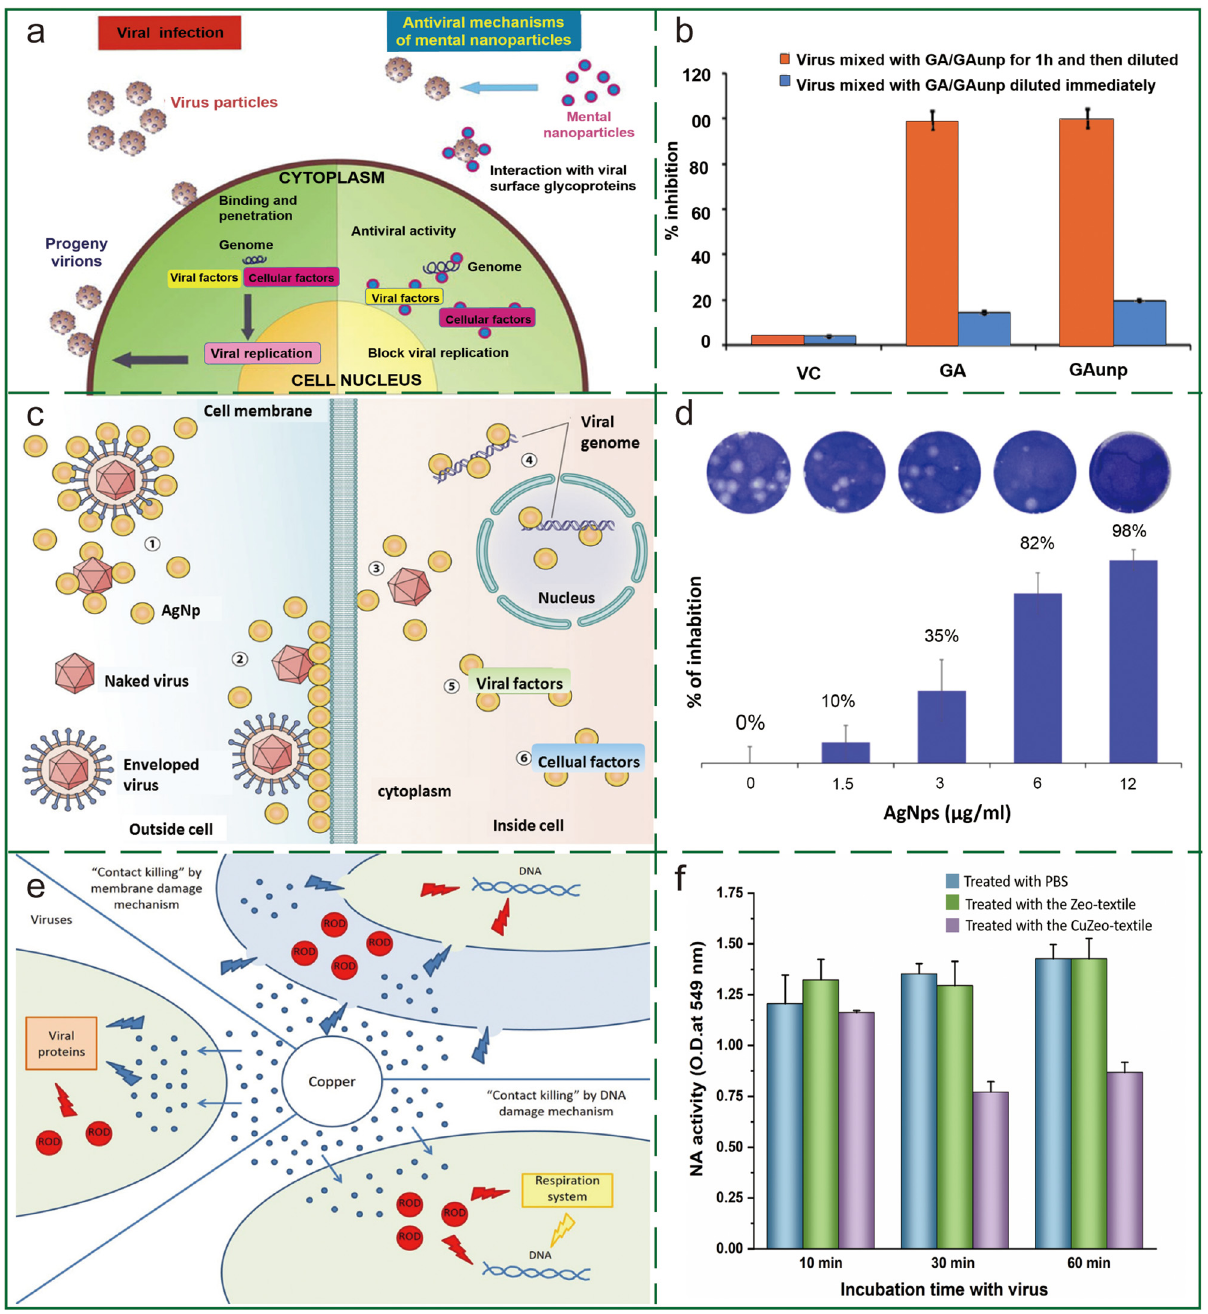
Figure 3: Antiviral mechanisms and antiviral activity of metals and their compounds. ( a ) Antiviral mechanism of metal nanoparticles [ 11 ] . ( b ) E ff ect of test compounds on the inactivation of HSV - 1 [ 15 ] . ( c ) Potential antiviral principles of silver nanoparticles [ 27 ] . ( d ) The e ff ect of AgNP on RVFV infection in Vero cells [ 25 ] . ( e ) Antimicrobial contact killing mechanisms for copper include membrane degradation, genotoxicity, and potentially ROS [ 39 ] . ( f ) Inhibition of the Ck/Yamaguchi/7/04 H5N1 virus NA after treatment with CuZeo - textile [ 38 ]